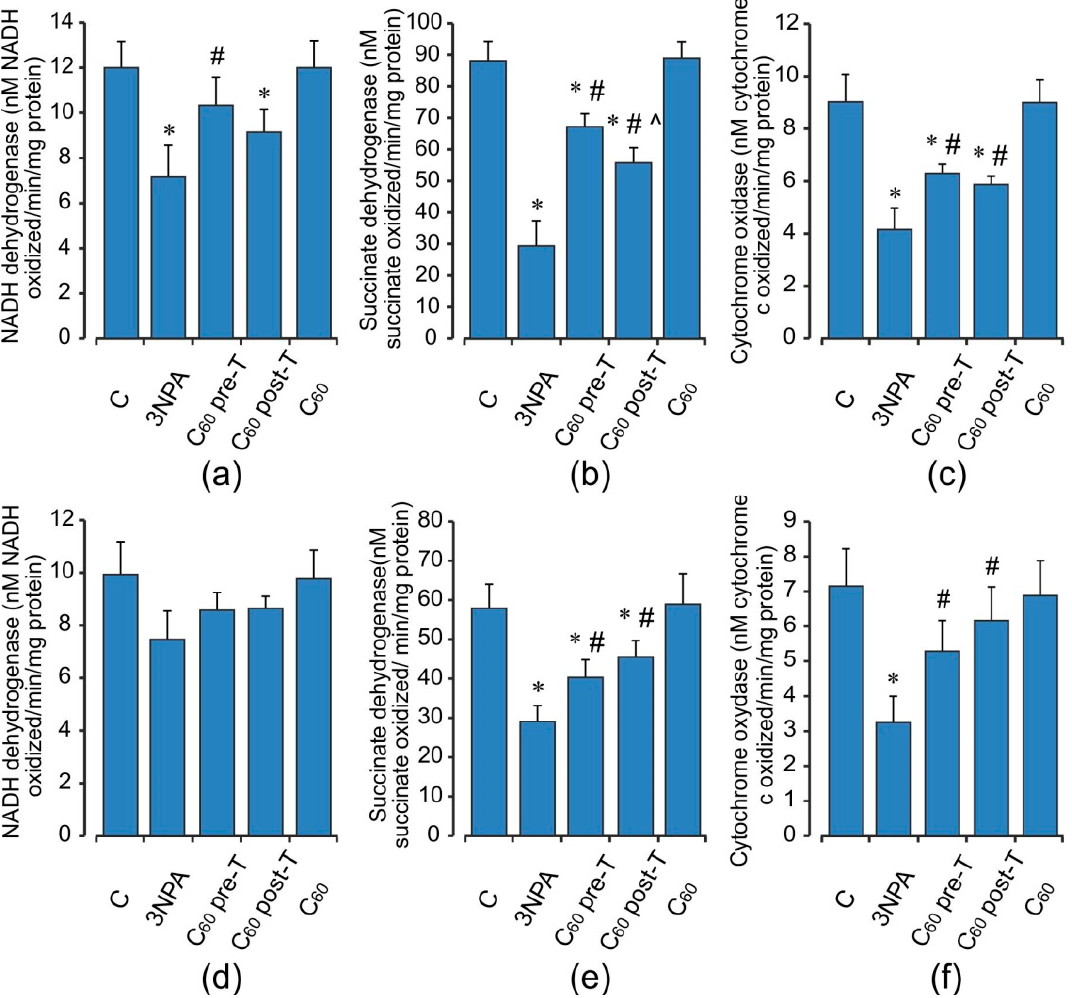
Figure 6. Effect of C 60 and 3-NPA administration on the activity of the respiratory chain enzymes: NADH dehydrogenase ( a , d ), Succinate dehydrogenase ( b , e ), Cytochrome oxidase ( c , e ) in brain ( a – c ) and skeletal muscle ( d – f ) mitochondria. Values are means ± SD (replicates=8). The data were analyzed for statistical significance using ANOVA followed by the Bonferroni post hoc test. (C)—control; (3NPA)—3-nitropropionic acid treated rats; (C 60 pre-T)—C 60 administration in pre-treatment regimen; (C 60 post-T)—C 60 administration in post-treatment regimen; (C 60 )—C 60 administration alone. * p < 0.05 vs. control group; # p < 0.05 vs. 3-NPA treated rats; ^ p < 0.05 vs. C 60 pre-T group.